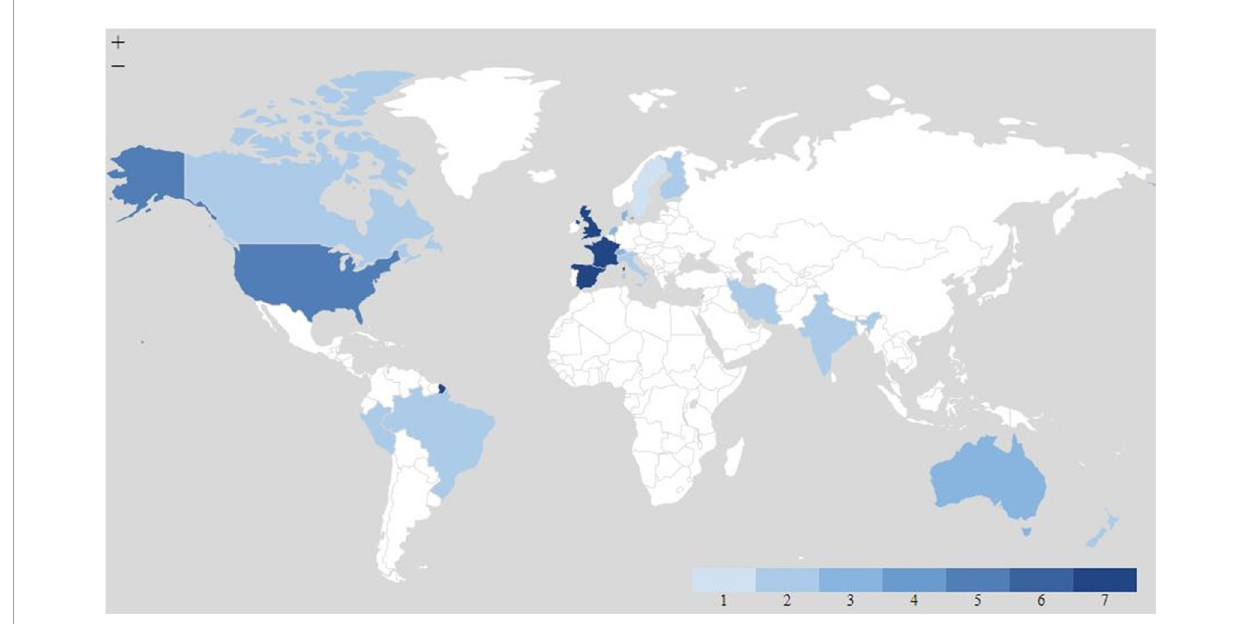
FIGURE4 Geographic distribution of study country or region. This map does not include one European study and four global studies.